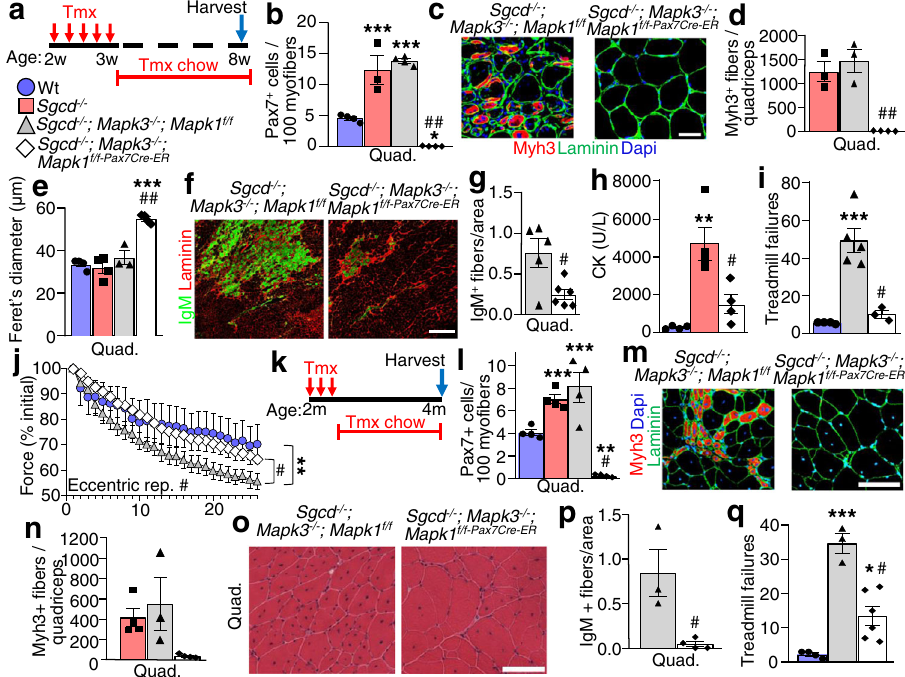
Fig. 2 Loss of satellite cells reduces muscle damage in Sgcd − / − mice. a Schematic showing 2-week-old mice receiving a daily Tmx injection for 5 consecutive days and then placed on Tmx chow after weaning until 8 weeks, which applies to all the data in panels b – j . b Quanti fi cation of Pax7 + satellite cells in muscle sections from the quadriceps (Quad) of mice with the indicated genotypes. n = 3 mice for Sgcd − / − samples and n = 4 mice for all other genotypes. One-way ANOVA with Tukey ’ s multiple comparisons test was used to determine signi fi cance, *** P < 0.001 vs Wt, ## P < 0.001 vs disease controls. c Representative quad muscle sections immunostained for Myh3 (red) and laminin (green) in 2-month-old mice of the indicated genotypes. Dapi stained nuclei are in blue. Scale bar = 50 μ m. d Quanti fi cation of the number of Myh3 positive fi bers in Quad muscle sections of mice with the indicated genotypes. n = 3 mice for Sgcd − / − and Sgcd − / − ; Mapk3 − / − ; Mapk1 f/f samples and n = 4 mice for Sgcd – / – ; Mapk3 − / − ; Mapk1 f/f-Pax7Cre-ER samples. One-way ANOVA with Tukey ’ s multiple comparisons test was used to determine signi fi cance, ## P < 0.001 vs disease controls. e Average minimal feret ’ s diameter of myo fi bers measured from muscle sections of the Quad in mice with the indicated genotypes. n = 4 Wt mice; 4 Sgcd − / − mice; 3 Sgcd − / − ; Mapk3 − / − ; Mapk1 f/f ; mice and 4 Sgcd − / − ; Mapk3 − / − ; Mapk1 f/f-Pax7Cre-ER mice. A 1-way ANOVA with Tukey ’ s multiple comparisons test was used to determine signi fi cance, *** P < 0.001 vs Wt, ## P < 0.001 vs disease controls. f Representative histological sections of the Quad muscle immunostained for immunoglobulin M (IgM) (green) and for laminin (Red) in mice of the indicated genotypes. Scale bar = 500 μ m. g Quanti fi cation of IgM positive fi bers in Quad muscle sections from mice of the indicated genotypes. n = 5 mice, Sgcd − / − ; Mapk3 − / − ; Mapk1 f/f ; n = 6 mice, Sgcd − / − ; Mapk3 − / − ; Mapk1 f/f-Pax7Cre-ER . Signi fi cance was determined using a two-tailed Student ’ s t test, # P = 0.01. h Average blood creatine kinase (CK) levels from mice of the indicated genotypes at 8 weeks of age. n = 4 mice in each group. One-way ANOVA with Tukey ’ s multiple comparisons test was used to determine signi fi cance, and ** P < 0.01 vs Wt, # P < 0.05 vs Sgcd − / − . i Quanti fi cation of the number of shock pad visits calculated over 20 min from the start of the protocol. n = 4 Wt mice; n = 5 Sgcd − / − ; Mapk3 − / − ; Mapk1 f/f mice; n = 3 Sgcd − / − ; Mapk3 − / − ; Mapk1 f/f-Pax7Cre-ER mice. A 1-way ANOVA with Tukey ’ s multiple comparisons test was used to determine signi fi cance, *** P < 0.001 vs Wt, # P < 0.01 vs Sgcd − / − ; Mapk3 − / − ; Mapk1 f/f . j Percent change in force transduction for the hindlimb muscles subjected to continuous repetitive eccentric contractions in the 3 genotypes of mice shown based on the key in panel “ a ” . The x -axis shows number of progressive repetitive (rep) contractions. A two-way repeated measures ANOVA with a Holm-Sidak post-hoc test was used to determine signi fi cance. n = 6 Wt mice; n = 7 Sgcd − / − ; Mapk3 − / − ; Mapk1 f/f mice; n = 4 Sgcd − / − ; Mapk3 − / − ; Mapk1 f/f-Pax7Cre-ER mice. ** P < 0.01 vs Wt, # P < 0.01 vs disease control. k Schematic representation of the Tmx treatment regimen, which applies to all the data in panels l – q . Two-month-old mice received a daily Tmx injection for 5 consecutive days and were subsequently placed on Tmx chow until 4 months of age. l Quanti fi cation of Pax7 + satellite cells in muscle sections from the Quad of mice with the indicated genotypes. n = 4 mice for all groups. A 1-way ANOVA with Tukey ’ s multiple comparisons test was used to determine signi fi cance, ** P < 0.01 vs Wt, *** P < 0.01 vs Wt, # P < 0.001 vs disease controls. m Representative Quad muscle sections immunostained for Myh3 (red) and laminin (green) in 4-month-old mice of the indicated genotypes. Dapi stained nuclei are in blue. Scale bar = 100 μ m. n Quanti fi cation of the number of Myh3 positive fi bers in Quad muscle sections of mice with the indicated genotypes. n = 4 Sgcd − / − and Sgcd – / – ; Mapk3 − / − and Mapk1 f/f- Pax7Cre-ER mice and n = 3 Sgcd − / − ; Mapk3 − / − ; Mapk1 f/f mice. o Representative H&E-stained sections of the Quad muscle from 4-month-old mice of the indicated genotypes. Scale bar = 100 μ m. p Quanti fi cation of IgM positive fi bers in Quad muscle sections from mice of the indicated genotypes. n = 3 Sgcd − / − ; Mapk3 − / − ; Mapk1 f/f mice and n = 4 Sgcd − / − ; Mapk3 − / − ; Mapk1 f/f-Pax7Cre-ER mice. Signi fi cance was determined using a two-tailed Student ’ s t test, # P = 0.01. q Quanti fi cation of the number of shock pad visits calculated 10min from the start of the protocol. n = 4 Wt mice; n = 3 Sgcd − / − ; Mapk3 − / − ; Mapk1 f/f mice and n = 6 Sgcd − / − ; Mapk3 − / − ; Mapk1 f/f-Pax7Cre-ER mice. A 1-way ANOVA with Tukey ’ s multiple comparisons test was used to determine signi fi cance, * P <0.05 vs Wt, *** P <0.001 vs Wt, # P <0.001 vs Sgcd − / − ; Mapk3 − / − ; Mapk1 f/f . Data represent mean±SEM for all